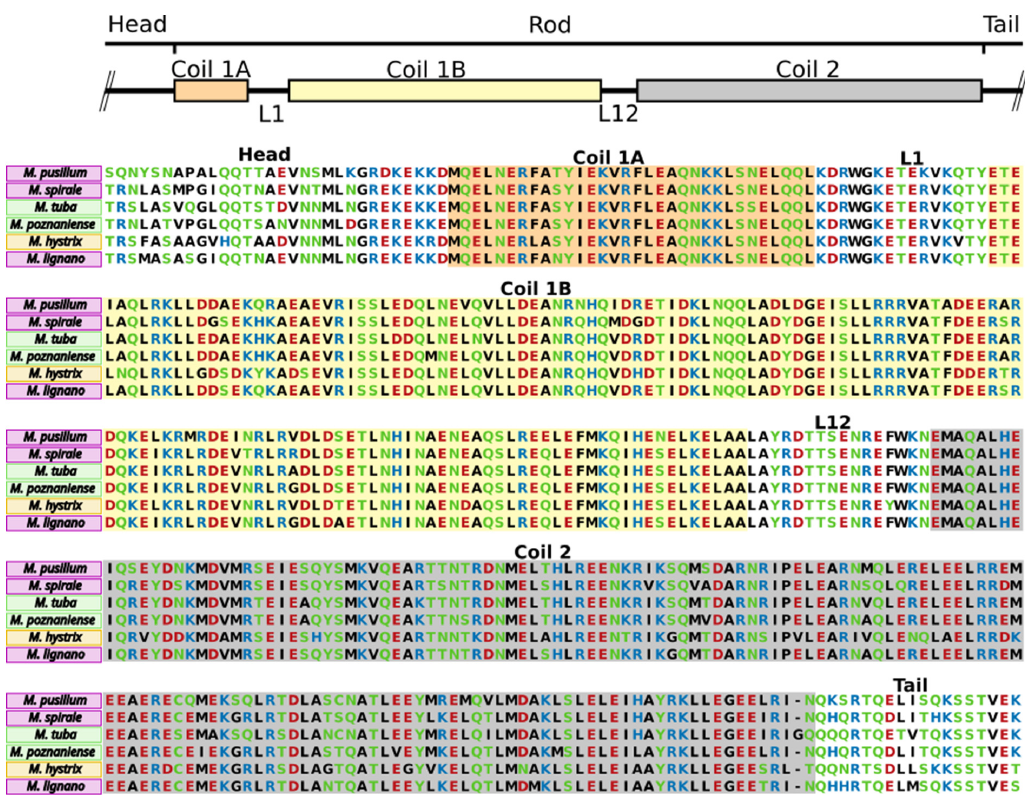
Figure 4. Conservation of the anchor cell-specific intermediate filament between six Macrostomum species. Alignment of Mlig-if1-like protein to its homologues in M. pusillum , M. spirale , M. tuba , M. poznaniense , and M. hystrix . Marine species outlined in pink, brackish species outlined in yellow, freshwater species outlined in green. The amino acid residues are coloured by their polarity: green neutral+polar; black neutral+non-polar; blue basic+polar; red acidic+polar). Coil1 is divided into Coil1A (highlighted in orange) and Coil1B (highlighted in yellow), linked by the linker region L1. Coil2 (highlighted in grey) is connected to Coil1B with the linker region L12.